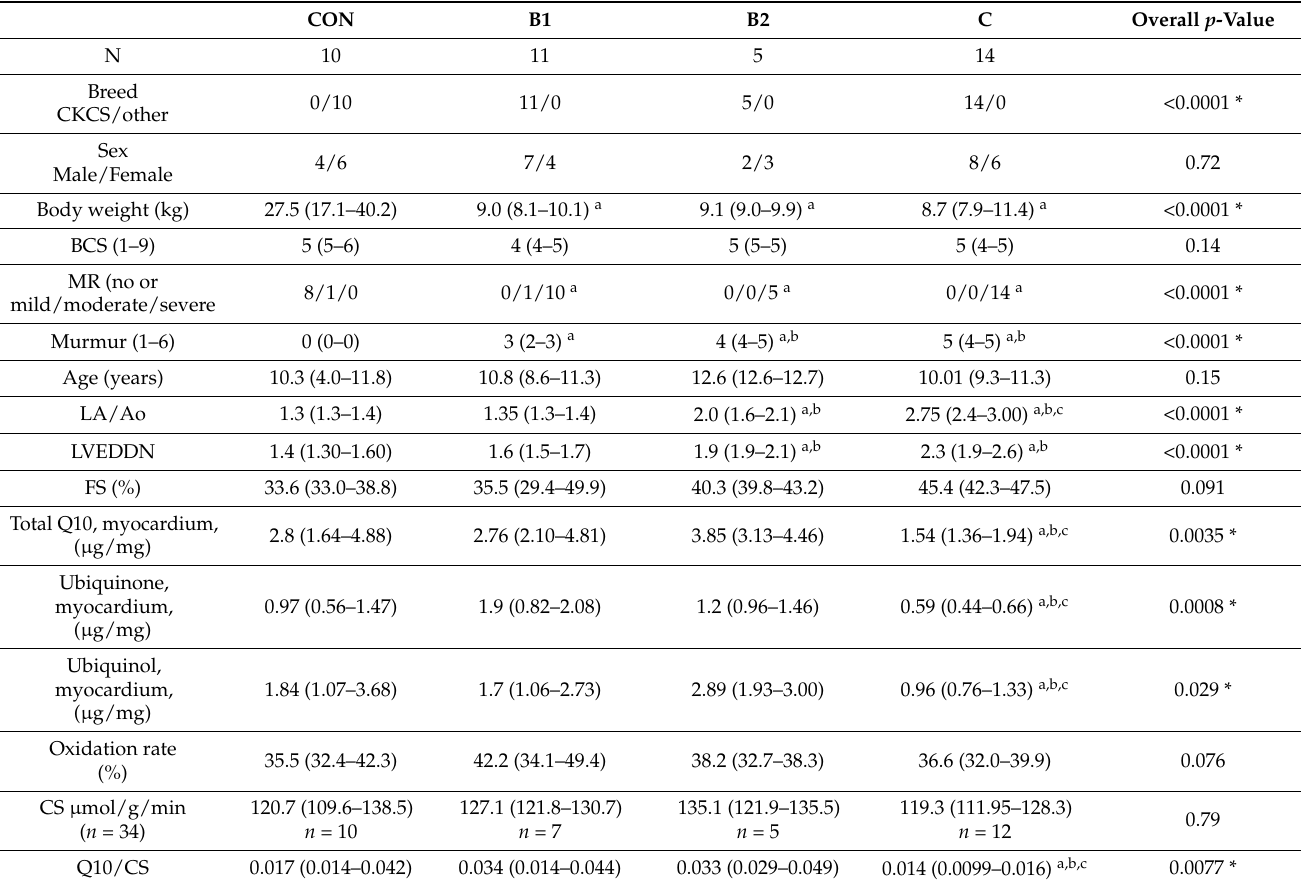
Table 1. Background characteristics, standard echocardiographic variables and myocardial concentrations of Q10 (total, reduced, oxidized), oxidation rate, CS activity and Q10/CS in control dogs and dogs with MMVD in different